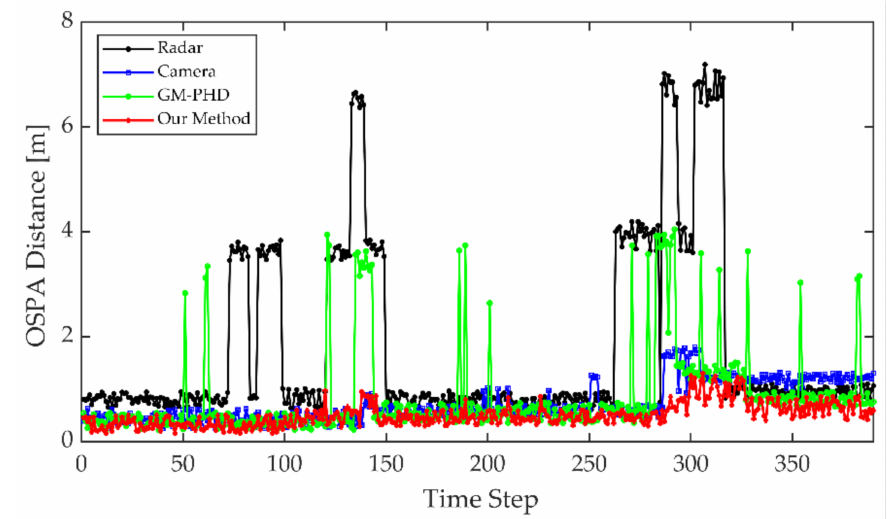
Figure 13. OSPA distance comparison for each tracking step.